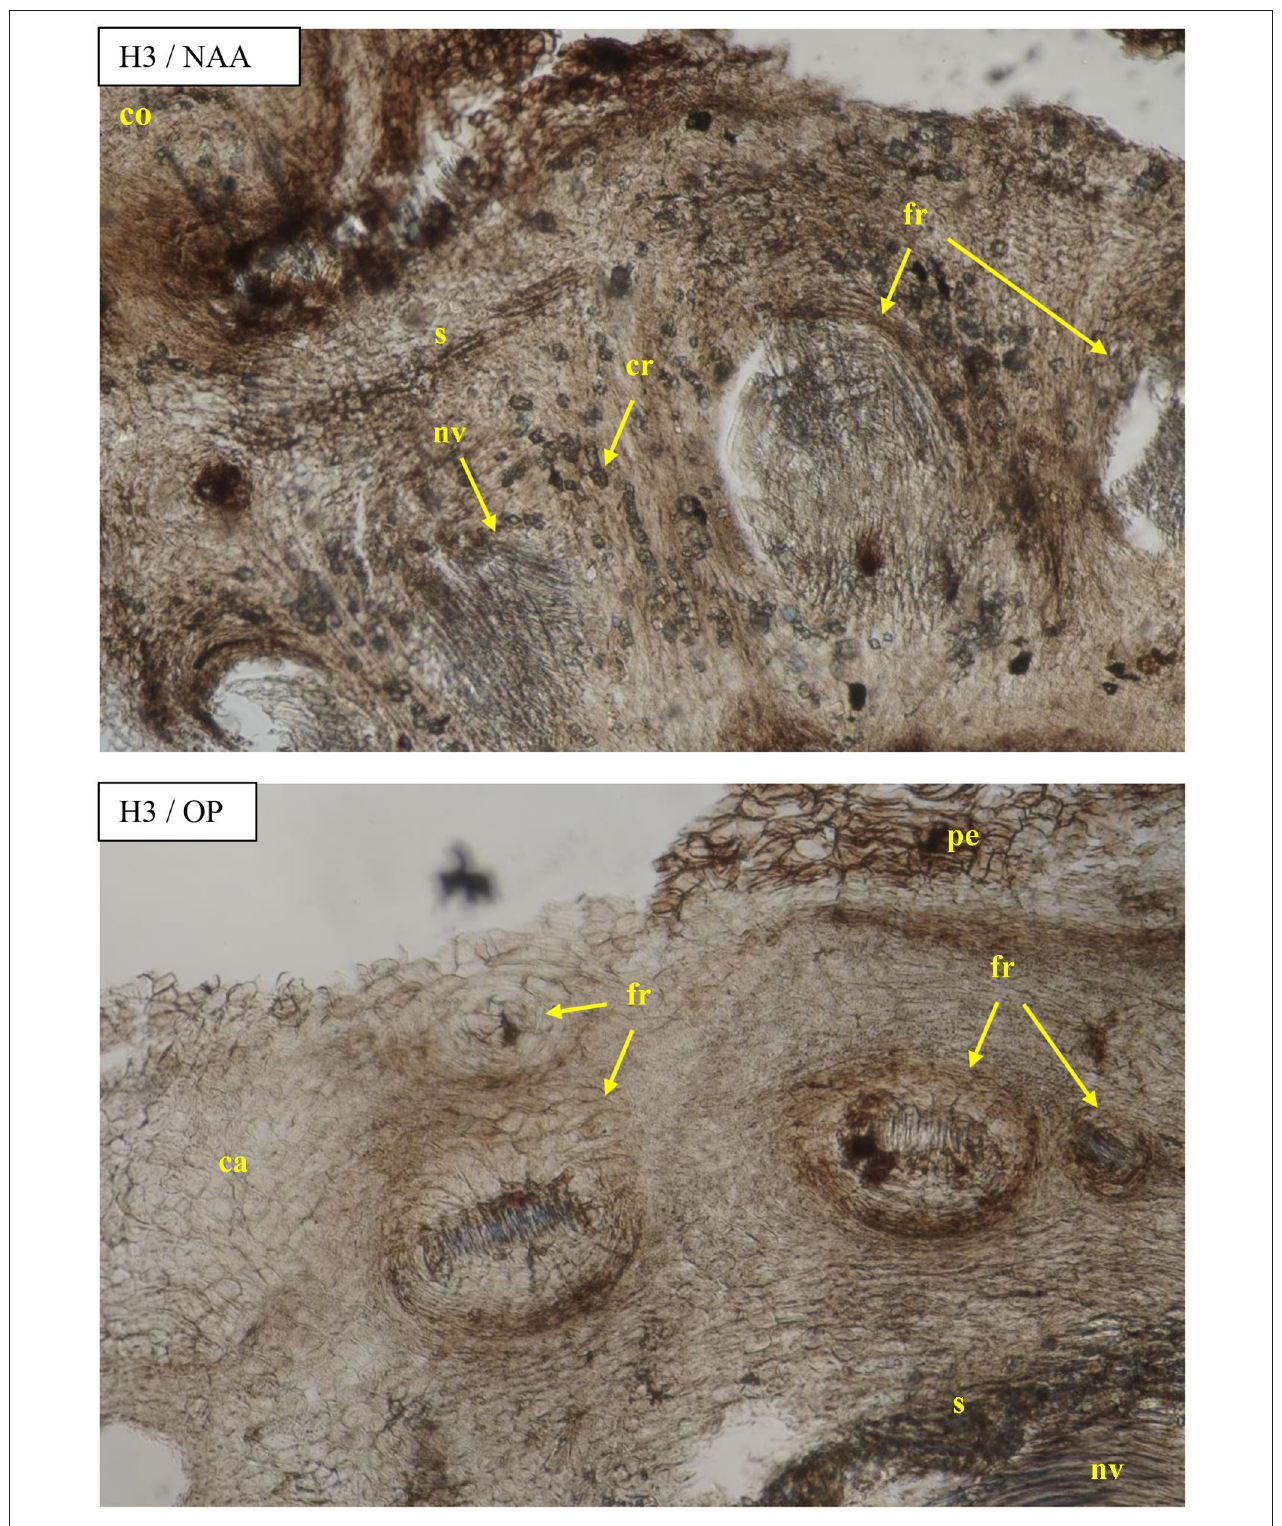
FIGURE 8 | Transverse sections of the shoots after 25 days of the process of rhizogenesis rooting in Rosa “Hurdal” in the phenological stage in BBCH scale (Meier et al., 2009) H3 − 69 629 (end of flowering of the second-order stem—all petals fallen) in control—the cuttings after treatment of NAA—Ukorzeniacz B aqua (0.2% NAA) and OP—Organic preparation—watering with 0.4% Root Juice TM (10ml) after planting. Designation of signs: ca, callus; co, cortex; cr, crystals; pe, periderm; s, sclerenchyma; nv, new vessels/vascular bundles; fr, forming root.